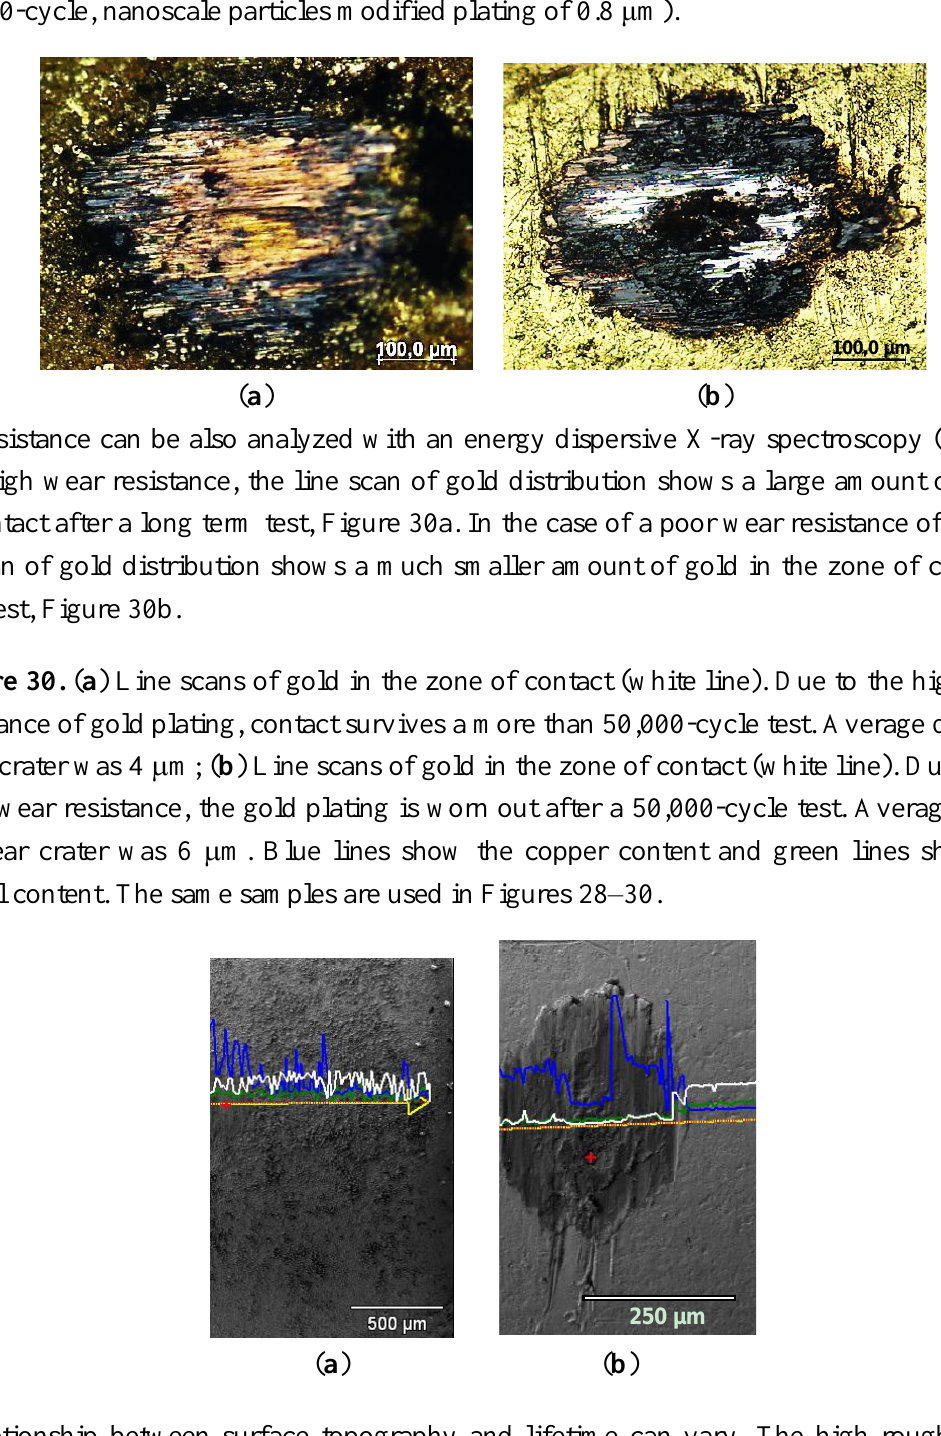
Figure 29. ( a ) Microscopy of zone of contact (average depth of wear crater: 4 μm, contacts ( b ) Microscopy of zone of contact (average depth of wear crater: 6 μm, contacts fail at 50,000-cycle, nanoscale particles modified plating of 0.8